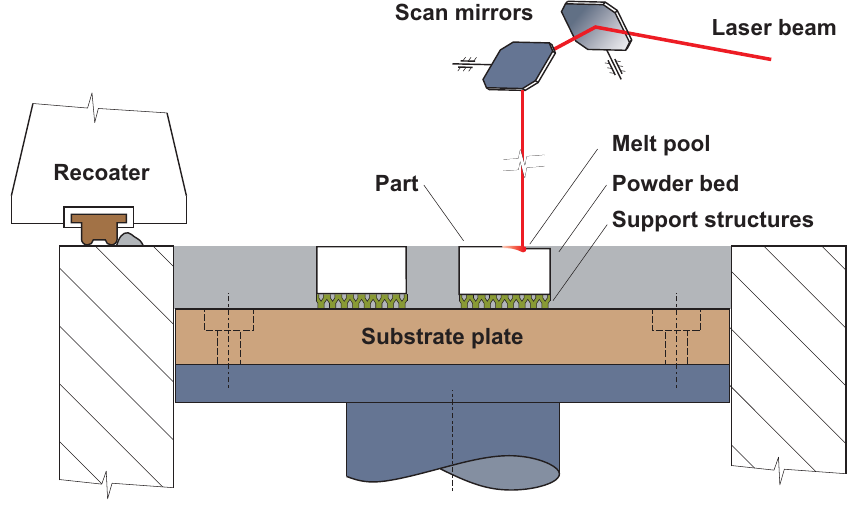
Figure 1. Basic principle of SLM